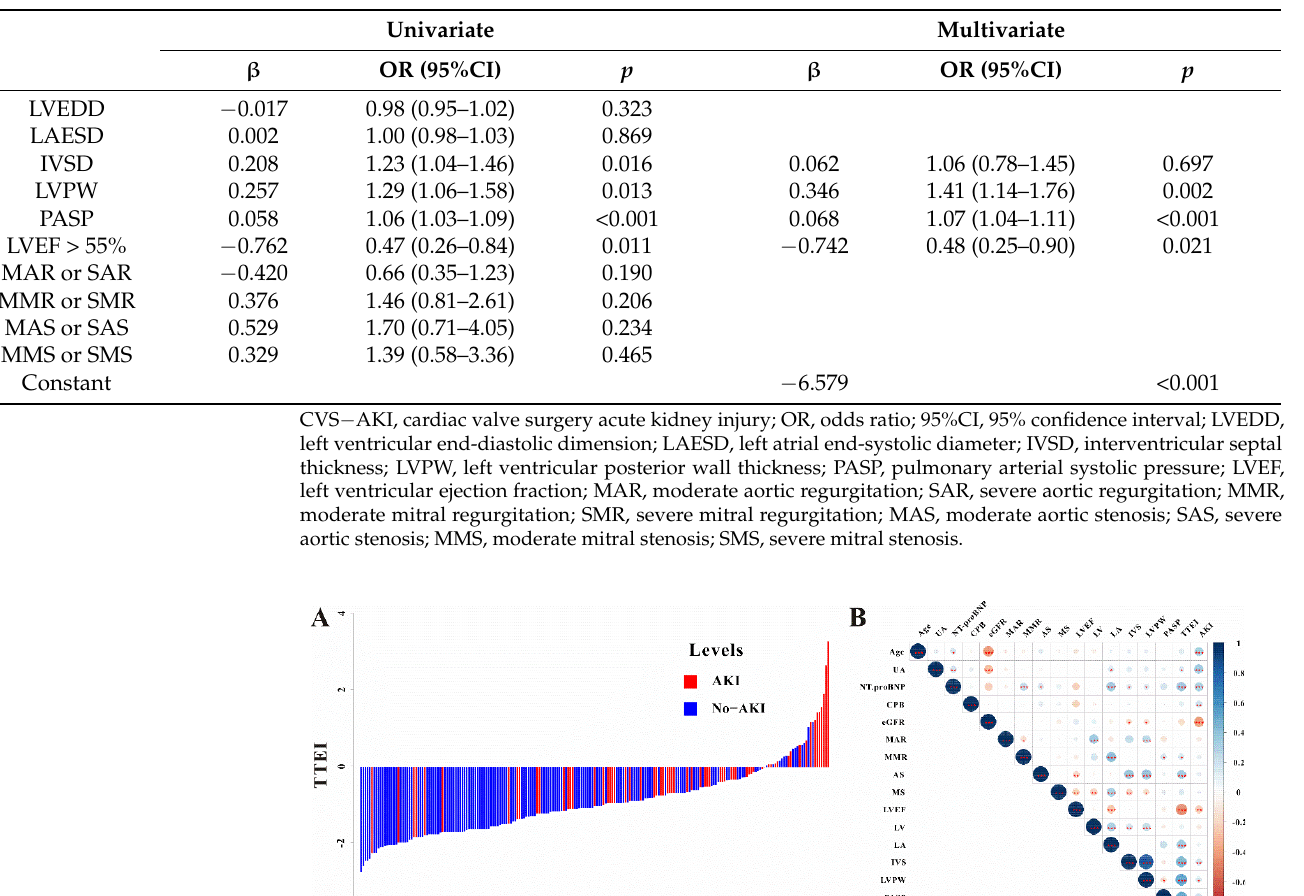
Figure 3. ( A ) The waterfall plot of TTEI value for each patient and ( B ) the relationship between TTEI and other TTE parameters and clinical features. * p < 0.05, ** p < 0.01, *** p <0.001. Based on the Youden index, all patients were divided into two groups according to the optimal cutoff value ( − 1.01). Patients in the high TTEI group had a higher risk of CVS − AKI (OR, 5.54, 95%CI, 2.88–10.68, p < 0.001) and the crude OR was 2.71 (95%CI 1.83–4.01, p < 0.001) when the TTEI value was used as continuous variables. The TTEI also showed a favorable predictive efficacy, with an AUC of 0.734 (95%CI 0.669–0.792; sensitivity, 75.8%; specificity, 64.0%). Moreover, in the pre-specified subgroup analysis, patients with TTEI ≤ − 1.01 had a lower risk of CVS − AKI than those with TTEI > − 1.01 group in almost all subgroups (Figure